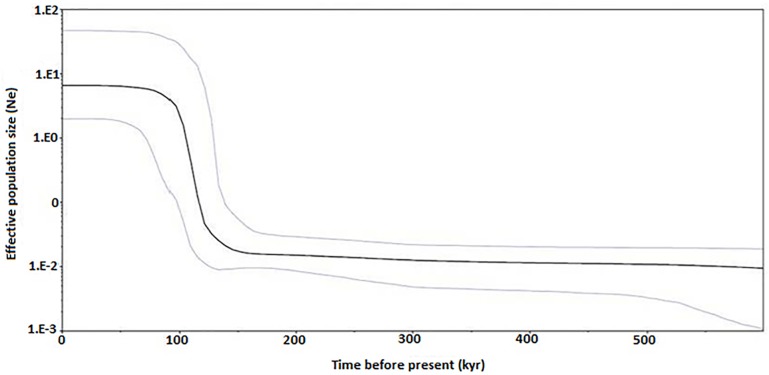
Bayesian skyline plot showing changes of effective population size (Ne) through time inferred with Beast based on mtDNA Cyt b sequences.Black line represents median estimate Ne; light lines are the upper and lower 95% highest posterior density (HPD) limits of Ne.